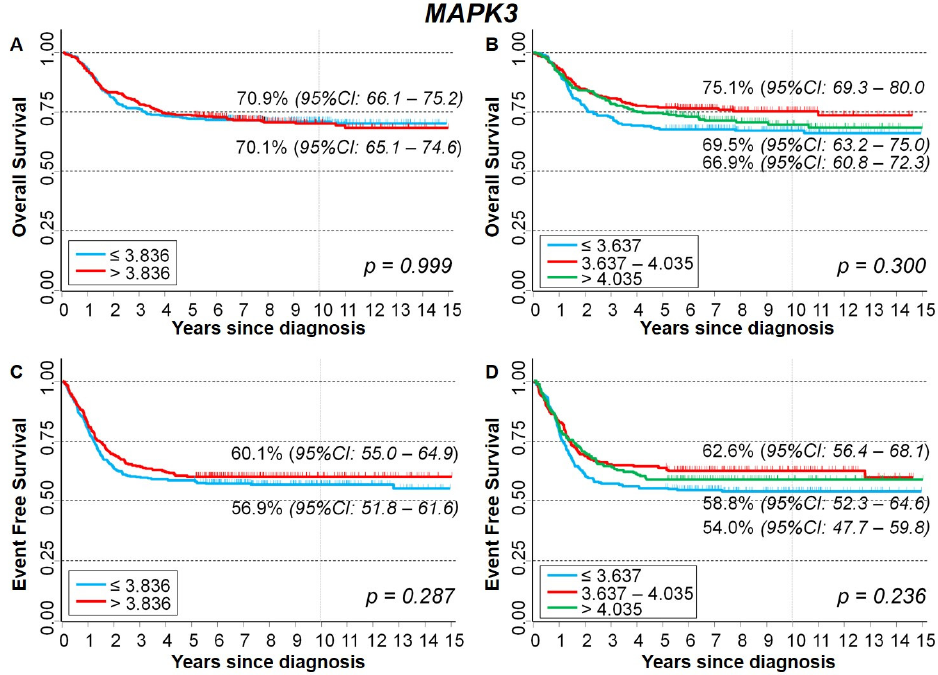
Figure 11. Kaplan–Meier survival curves of the whole cohort of 786 NB patients in relation to MAPK3 gene-expression values. ( A ) Overall survival, cut-off based on the median expression value; ( B ) Overall survival, cut-offs based on tertile expression values. ( C ) Event-free survival, cut-off based on the median expression value; ( D ) Event-free survival, cut-offs based on tertile expression values. Ten-year survival estimates are displayed. Table 5. Survival of the whole cohort of patients with NB in relation to MAPK3 gene-expression values, evaluated by the multivariable Cox regression model.